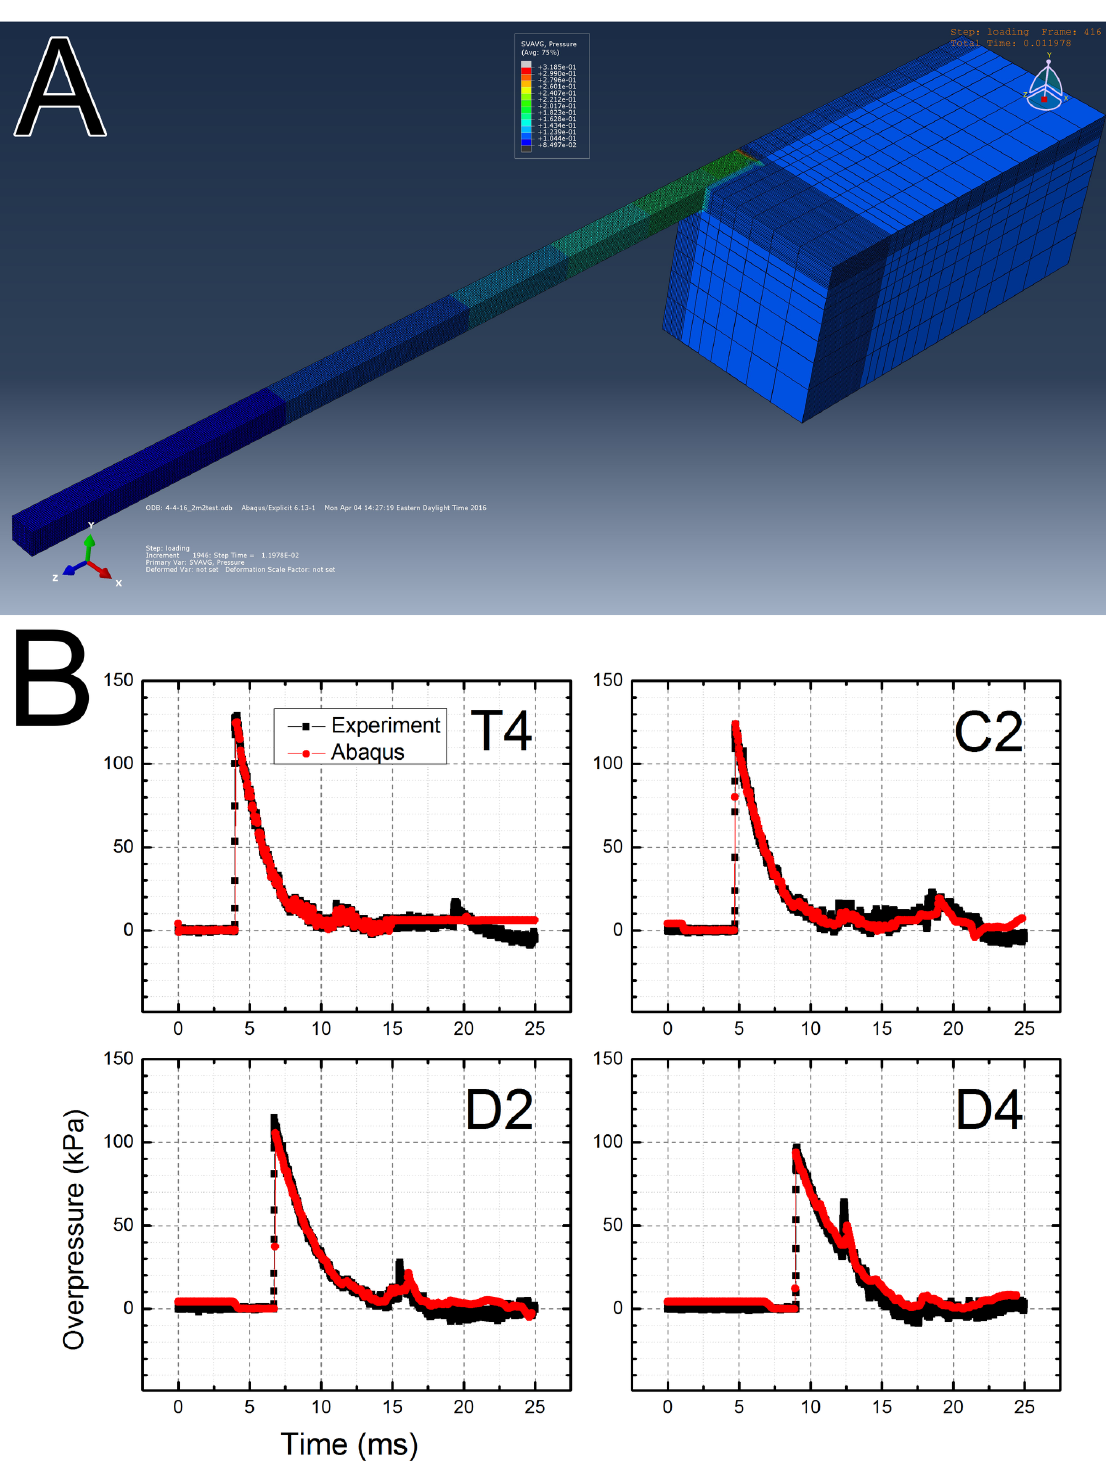
Fig 8. Numerical simulations: A) isometric view of the full scale model of the 9 inch square cross section shock tube, B) comparison of pressure traces recorded experimentally and obtained as results of numerical simulations with Abacus software for shock wave generated using 0.020 ” thick Mylar membrane and 2 inches end plate gap. Input feed for simulations was composed using initial 15 ms of the incident overpressure recorded by T4 sensor and 10 ms of baseline signal. This was done to eliminate secondary loading waveform from input data, which leads to erroneous